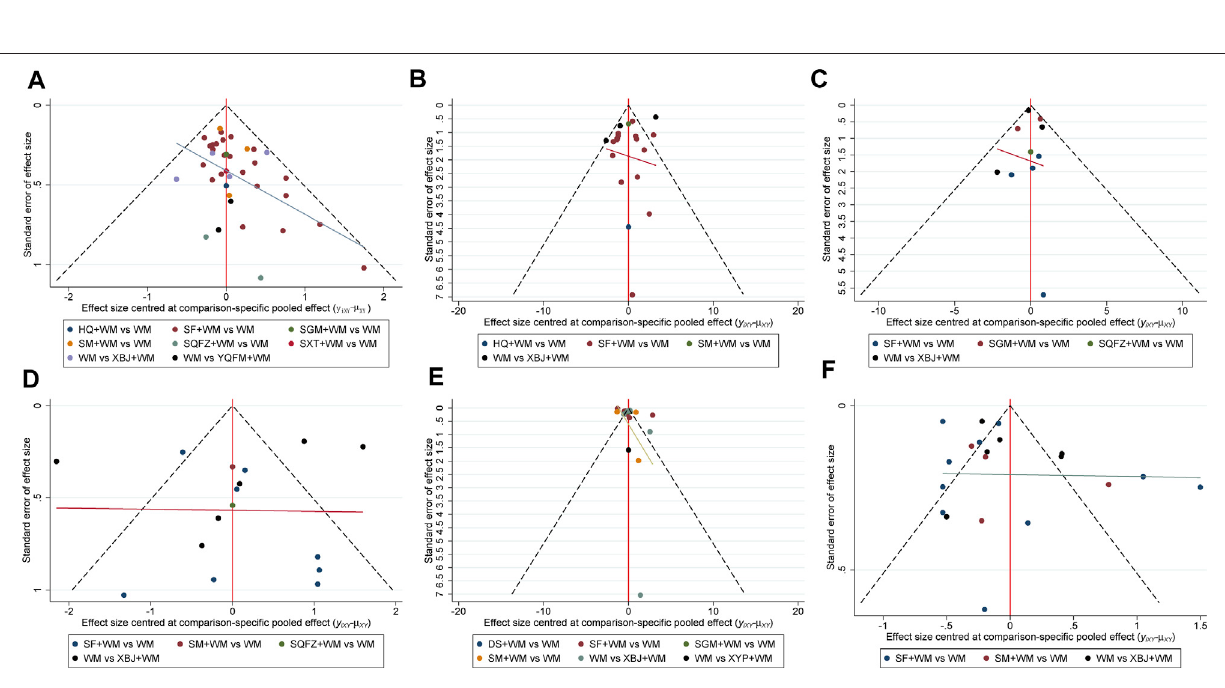
Frontiers in Pharmacology |